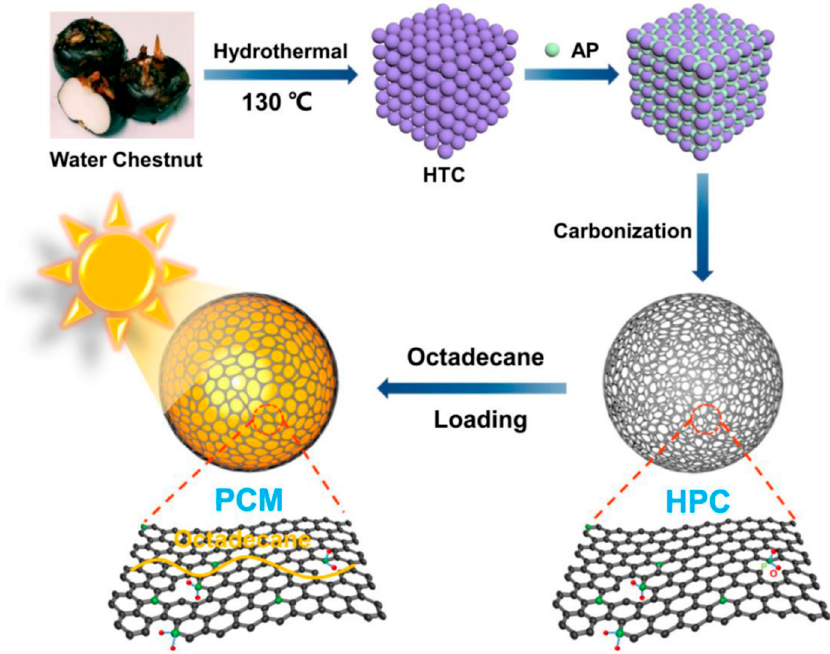
Figure 6. Preparation of composite PCMs with water chestnut and octadecane [71].